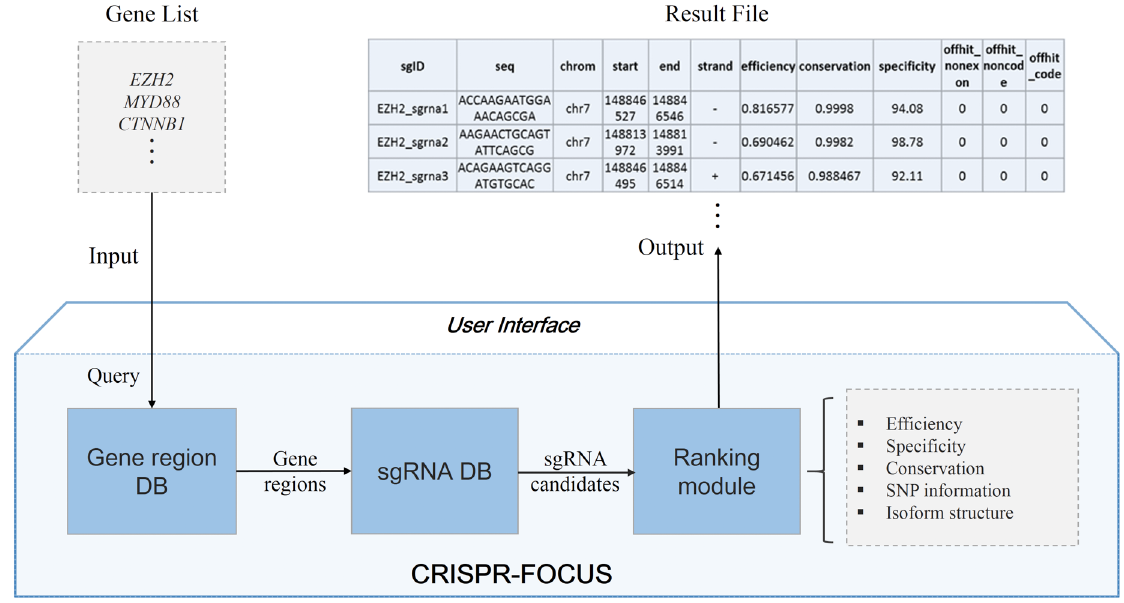
Fig 1. The main schemeof